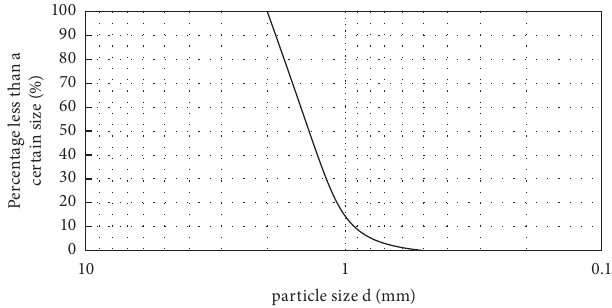
Figure 1: Grain size distribution curve of sand used in tests.